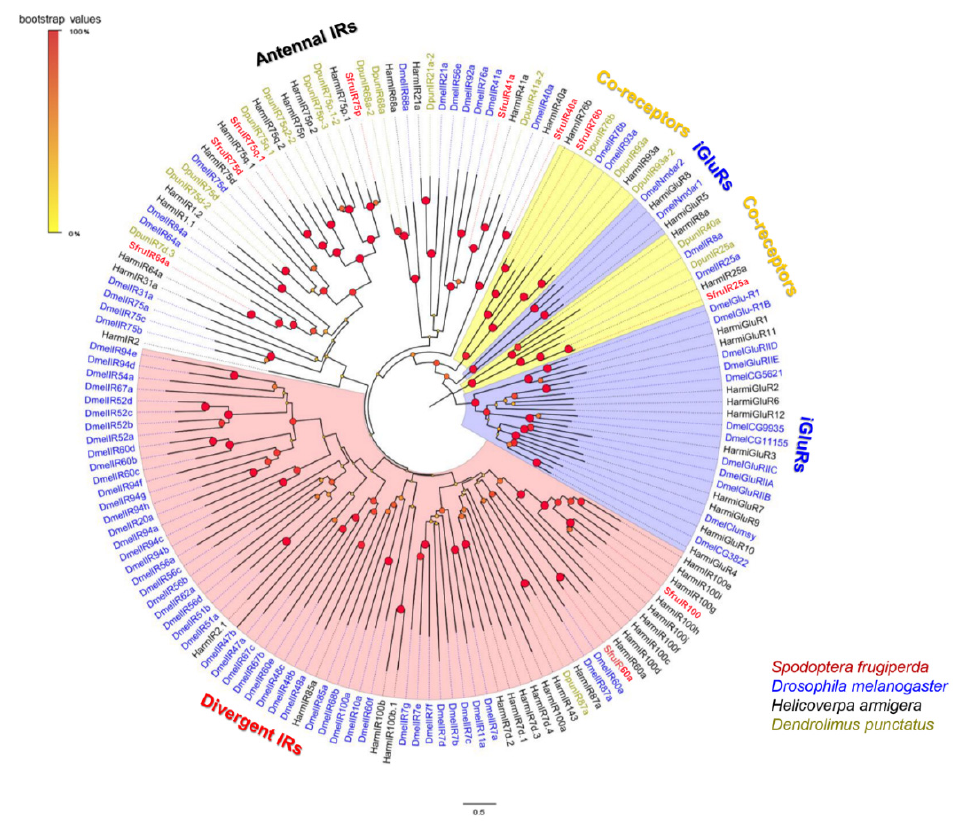
Figure 6. Neighbor-joining tree of candidate IRs from S. frugiperda (Sfru), H . armigera (Harm), D. punctatus (Dpun), and D. melanogaster (Dmel). Branches of IR co-receptors are highlighted in yellow; branches of the putative ionotropic glutamate receptors (iGluRs) are highlighted in blue; branches of the putative “divergent IRs” are highlighted in pink; branches of the putative “antennal IRs” are not highlighted.